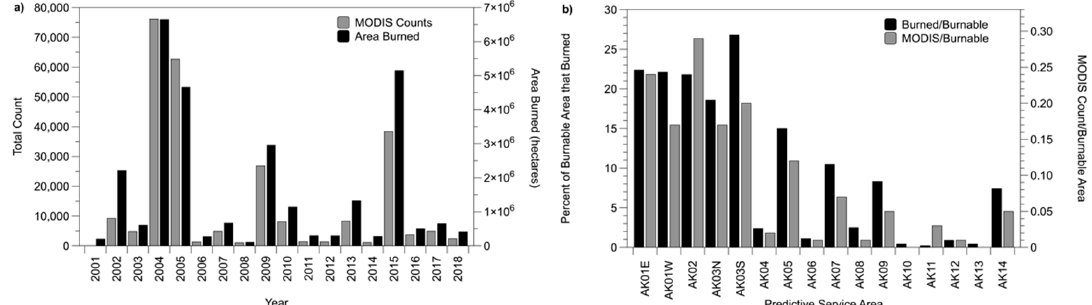
Figure 2. Temporal and spatial indicators of Alaska wildfire activity. ( a ) Comparison of year-to-year variability in area burned and MODIS detection counts for Alaska from 2001–2018 and ( b ) area burned and MODIS hotspot detections as a proportion of burnable area (i.e., lands sufficiently vegetated to accumulate dead fuel loads over time using historic review of vegetative greenness from remote sensing) for each Predictive Service Area (PSA) over the 2001–2018 period.